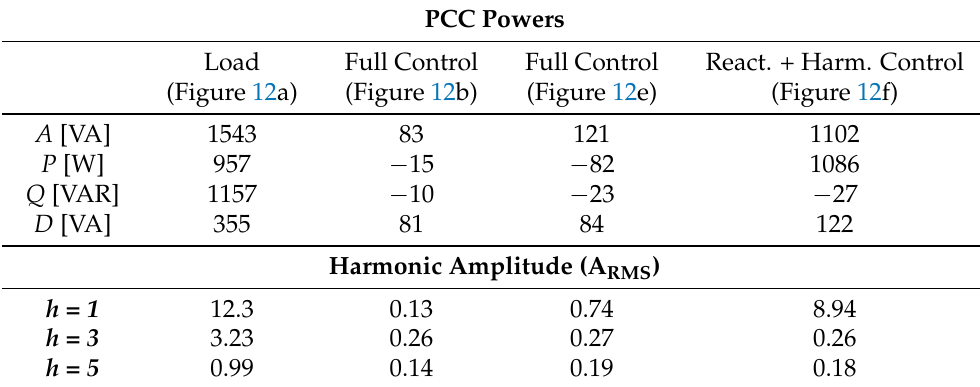
Table 6. Steady-state powers and current amplitudes at the PCC for Figure